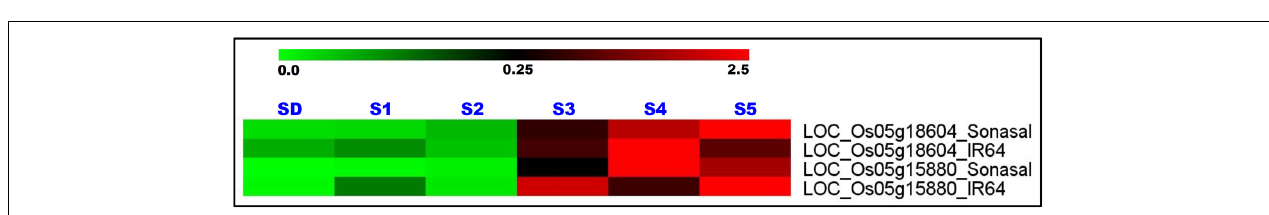
FIGURE 4 | Differential expression profiles of two genes (glycosyl hydrolase and serine carboxypeptidase) delineated at a novel 1.83 Mb major genomic region underlying the grain weight QTL ( OsqGW5.1 c ) (detected by integrating traditional QTL mapping with QTL region-specific SSR and SNP marker-based QTL-seq analysis) in diverse vegetative seedlings (SD) and reproductive five seed developmental stages (S1–S5) of low and high grain weight parental accessions of a mapping population (IR 64 × Sonasal). The average log signal expression value of genes in various tissues and developmental stages is represented at the top with a color scale; in which green, black and red color specify the low, medium and high level of expression, respectively. The tissues/stages and genes/mapping parental accessions utilized for expression profiling are designated on the top and right sides of expression map,